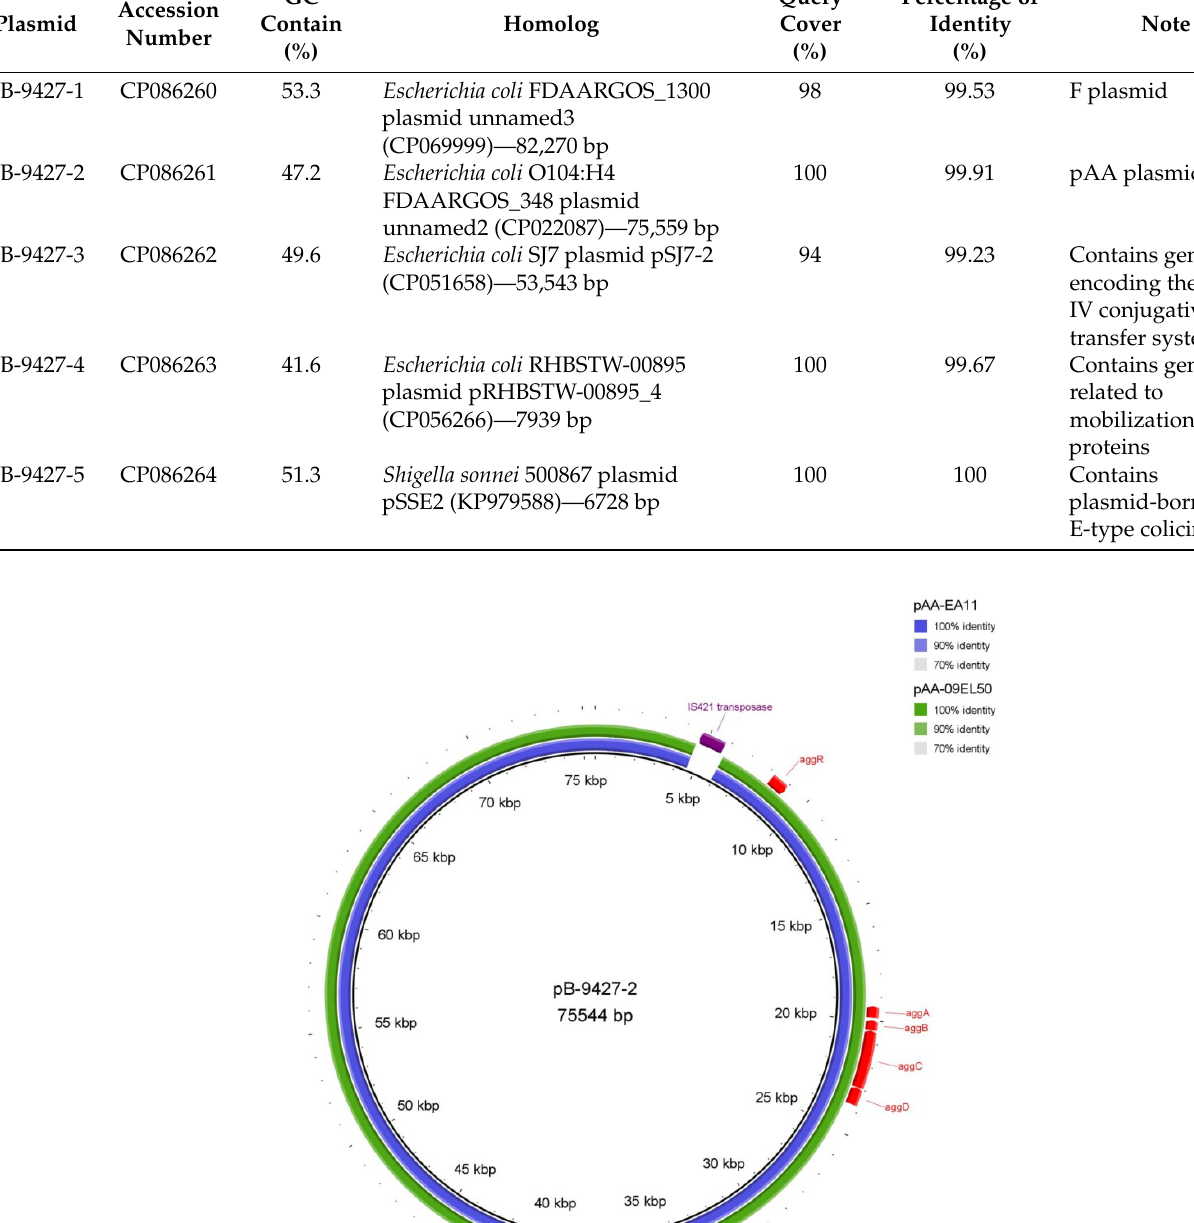
Table 4. Plasmids of the strain SCPM-O-B-9427.